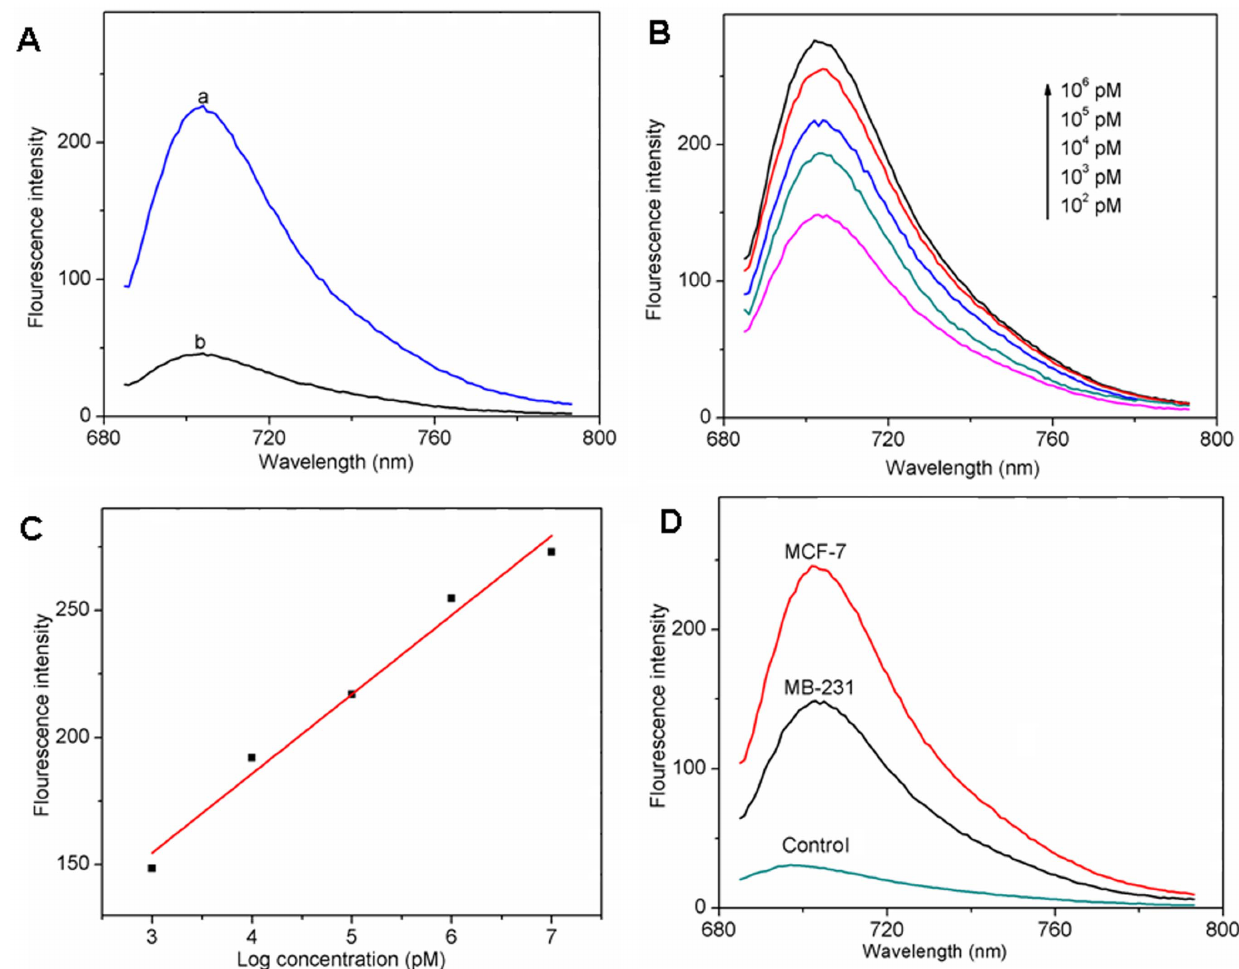
Figure 4. In vitro fluorescent detection of pre-microRNA. (A) Fluorescence spectra of (a) QD-RNA-Au NP and (b) QD-control RNA-Au NP probe loaded CS/ c -PGA complex in presence of target pre-miRNA. (B) Fluorescence spectra of QD-RNA-Au NP probe loaded CS/ c -PGA complex at different amounts of pre-miRNA and (C) linear plot of fluorescence intensity vs pre-miRNA amount. (D) Fluorescence spectra of the mixtures of QD-RNA-Au NP probe loaded CS/ c -PGA complex and 50 ng of total RNAs extracted from MCF-7 and MDA-MB-231 cells, 100 m l DEPC-treated water was used as control.